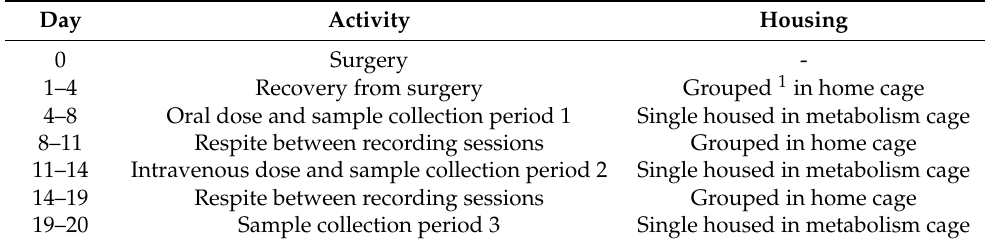
Table A1. Study design for the pin-port BDC validation